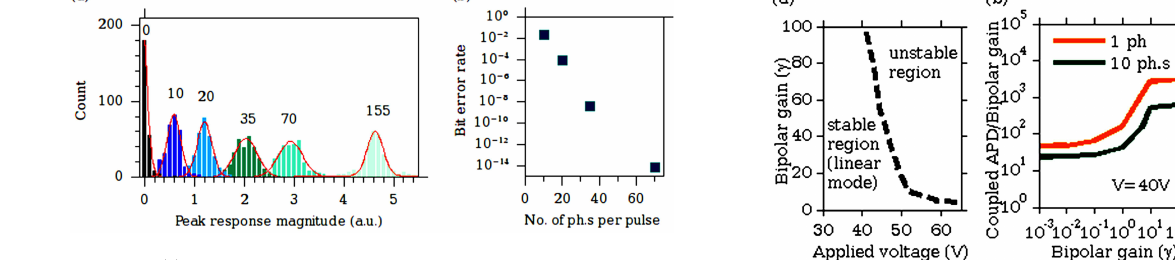
Figure 12: (a) Histogram for measured output response under dif- ferent photon numbers in the input pulse at 1550 nm wavelength. (b) Bit error ratio (BER) dependence on the number of photons per input pulse using the relation: BER = 1 2 erfc